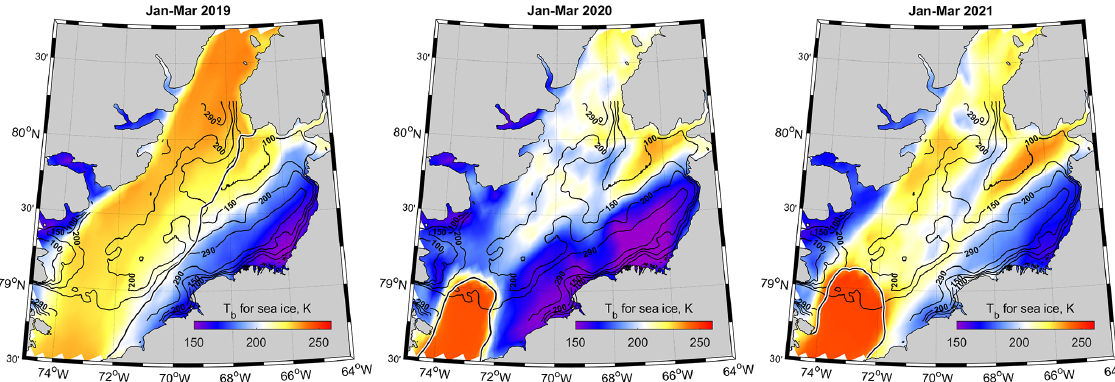
Figure 5. The mean AMSR2 brightness temperatures in January–March 2019, 2020 and 2021. The 100, 150, 200 and 250m isobaths are shown in background, whereas the black lines in the right panel correspond to approximate positions of landfast ice